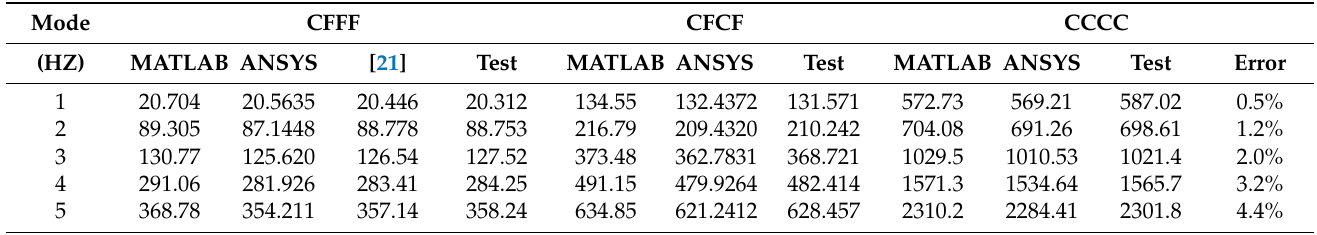
Table 1. Comparison of Natural Frequencies of base under Different Boundary